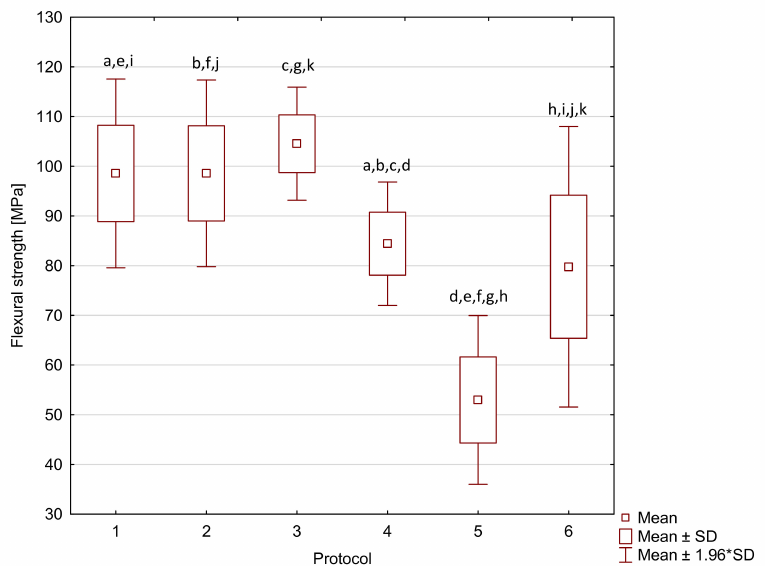
Figure A7. Box-and-whisker plot of three-point bending flexural strength (FS) of Arkon material. Statistically-significant differences were detected between the following: (a,b,c,d) Protocol 4 (water, 7500 thermocycles, 5/55 ◦ C) vs. (a) Protocol 1 (water, 24 h, 37 ◦ C) ( p = 0.008509); (b) Protocol 2 (artificial saliva, 90 days, 37 ◦ C) ( p = 0.008449); (c) Protocol 3 (water, 500 thermocycles, 5/55 ◦ C) ( p = 0.000340); (d) Protocol 5 (0.1 M NaOH, 7 days, 60 ◦ C) ( p = 0.000000); (e,f,g,h) Protocol 5 (0.1 M NaOH, 7 days, 60 ◦ C) vs. (e) Protocol 1 (water, 24 h, 37 ◦ C) ( p = 0.000000); (f) Protocol 2 (artificial saliva, 90 days, 37 ◦ C) ( p = 0.000000); (g) Protocol 3 (water, 500 thermocycles, 5/55 ◦ C) ( p = 0.000000); (h) Protocol 6 (water, 5 days, 55 ◦ C) ( p = 0.000006); (i,j,k) Protocol 6 (water, 5 days, 55 ◦ C) vs. (i) Protocol 1 (water, 24 h, 37 ◦ C) ( p = 0.000721); (j) Protocol 2 (artificial saliva, 90 days, 37 ◦ C) ( p = 0.000716); (k) Protocol 3 (water, 500 thermocycles, 5/55 ◦ C) ( p =